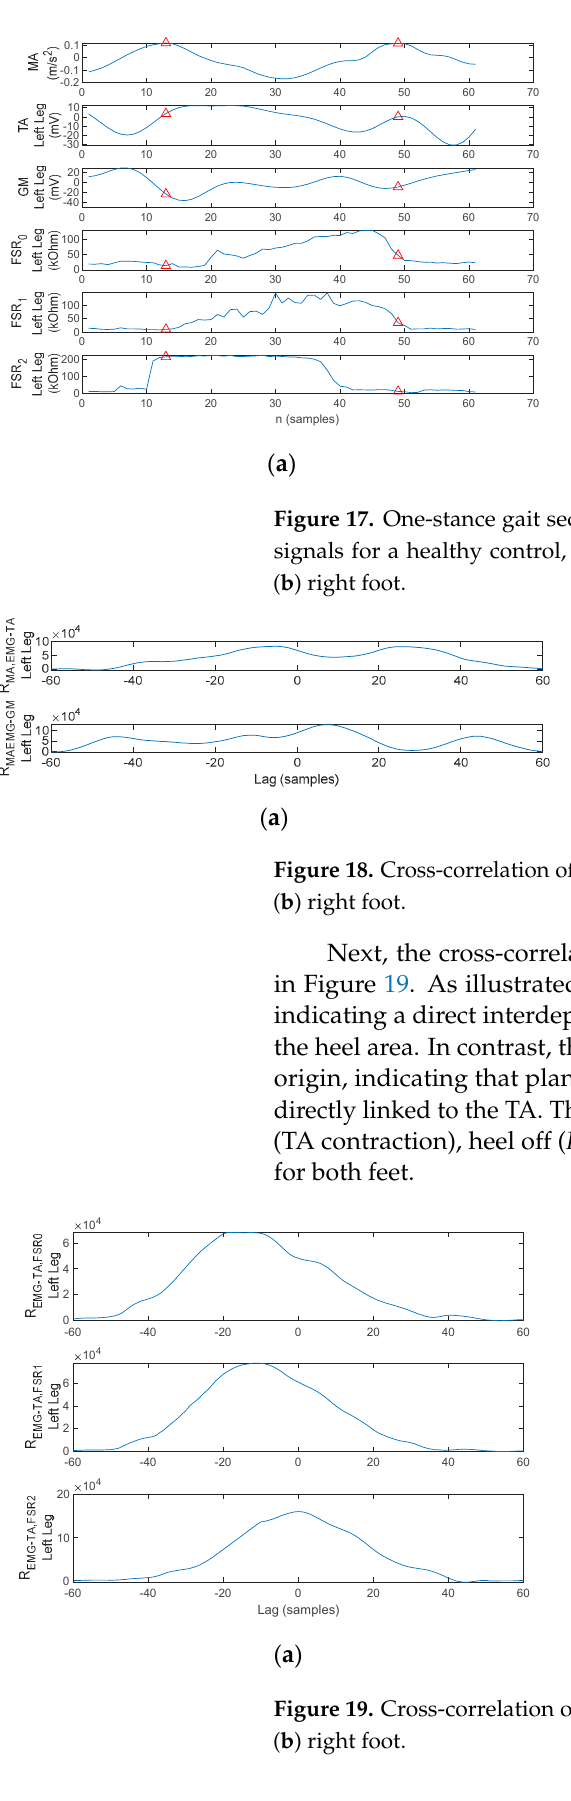
Right: 1.9 ± 1.6 What stands out in both Healthy control group and PD group is that the cadence is considerably smaller than the nominal 60 steps/min [52,53]. Both healthy controls and PD patients expressed that their pace was reduced because of physiograph wiring. The PD group exhibits reduced percentage of single support and S/D in comparison to the healthy control group, while the percentage of double support is not significantly different. On the other hand, stride time variability is increased for the PD group in con- trast to the healthy control group. What stands out for the PD group is that Patient 4 exhibits a very small percentage of single support with the left leg. This is because Patient 4 has a very small right leg lift- off during the swing phase of the gait cycle. 3.2. Gait Assessment—Cross-Correlation As discussed in Section 2, a physiological gait pattern assumes some specifically de- fined interdependencies between the plantar pressure, lower-limb muscular activation, and arm balance, assessed using the cross-correlation function. Illustration of the cross- correlation between the signals acquired with the proposed physiograph is presented